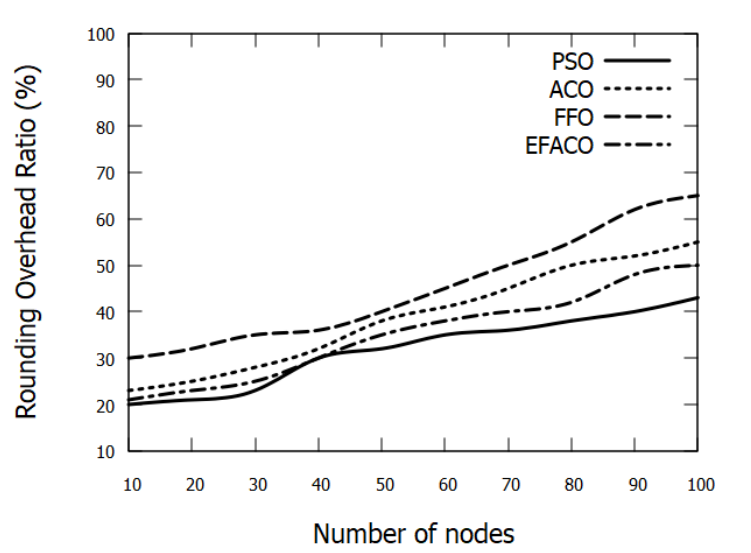
Figure 13. Comparison between proposed PSO, ACO, FFO, EFACO for Rounding Overhead with number of nodes.